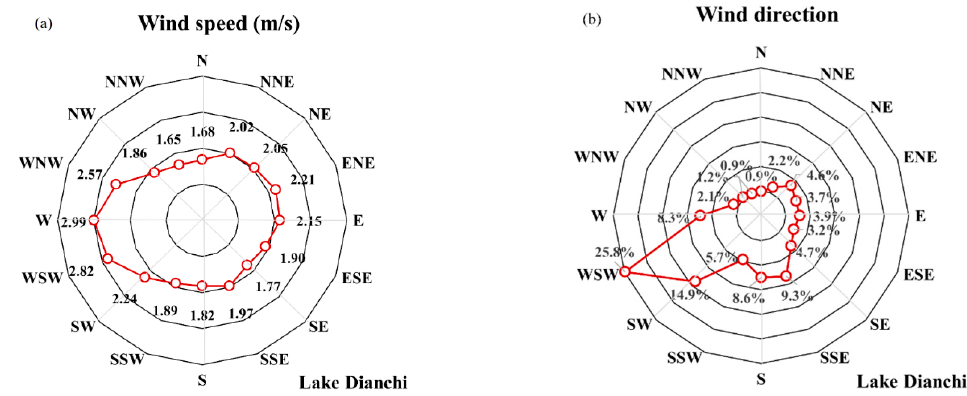
Figure 19. Statistical rose maps of interannual winds in Lake Dianchi during 2000–2018. ( a ) Wind speed; ( b ) wind direction.